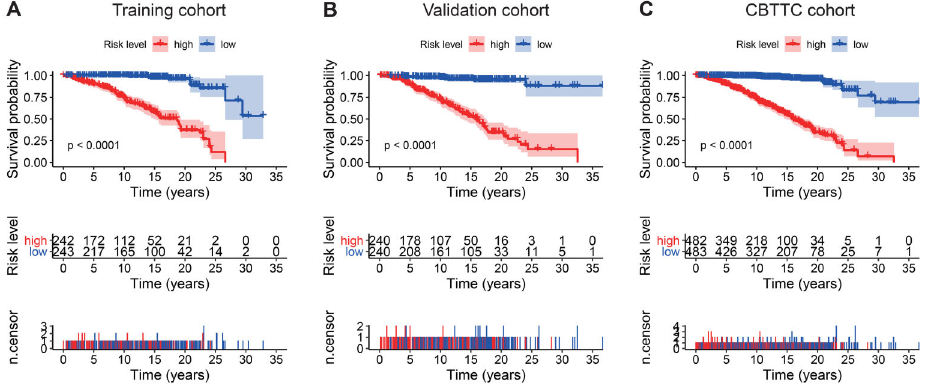
Figure 3. Characteristics of the eight-gene signature. Upper and middle, the distribution of risk score and patient ’ s survival time for training ( A ), validation ( B ), and Pediatric Brain Tumor Atlas (CBTTC) ( C ) cohorts. The black dotted line is the median cutoff dividing patients into low-risk and high-risk groups. Bottom, heatmap of the eight-gene expression pro fi les for prognostic signature for training, validation, and CBTTC cohorts.